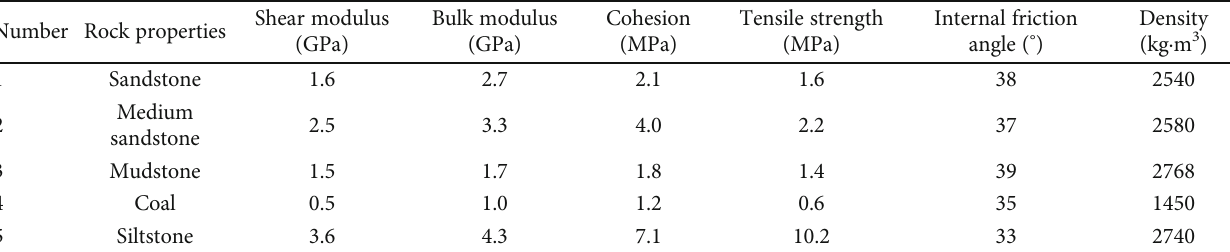
Table 4: Physical and mechanical parameters of rock.